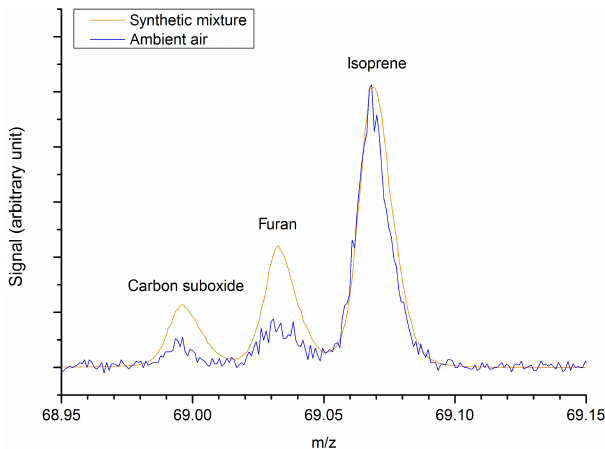
Figure 1. PTR-TOF-MS mass spectrum of a synthetic mixture of carbon suboxide, furan and isoprene, and of ambient air in Mainz, Germany. The peak heights are normalized to that of